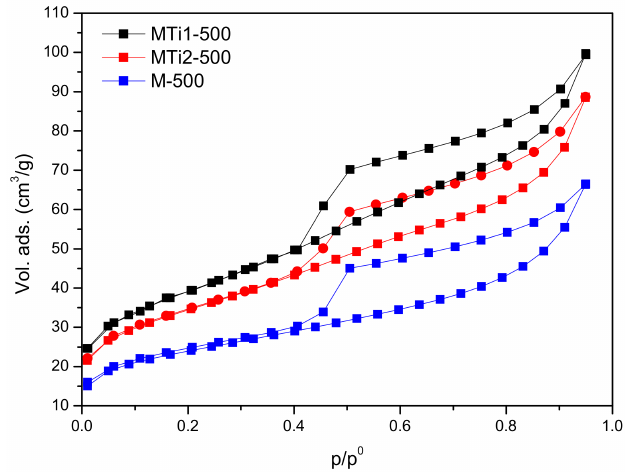
Figure 5. Nitrogen adsorption–desorption isotherms of the calcined solids.